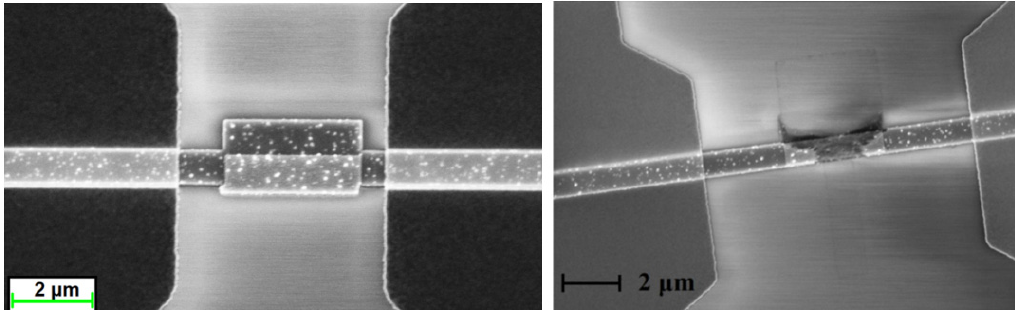
Figure 11. SEM images with examples of SINIS detectors with a suspended Hafnium absorber be- fore ( left ) and after ( right ) aluminum etching under the absorber [33].